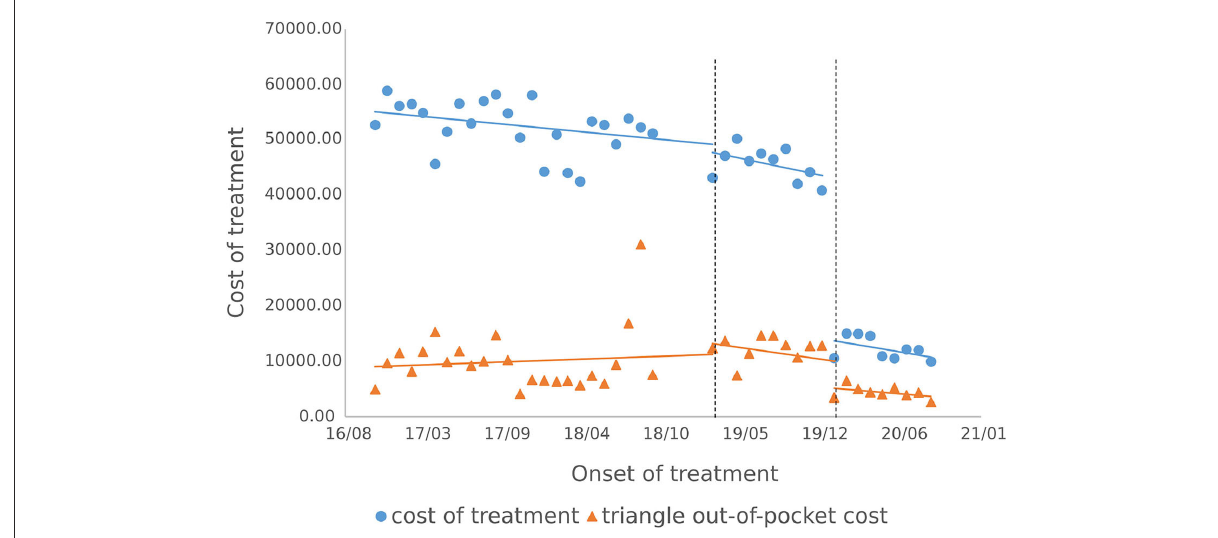
FIGURE5 Total treatment expense of hepatitis C patients.